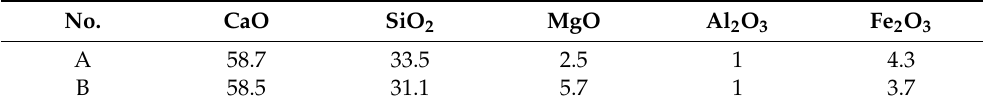
Table 1. Composition of magnesium slag (mass fraction %).